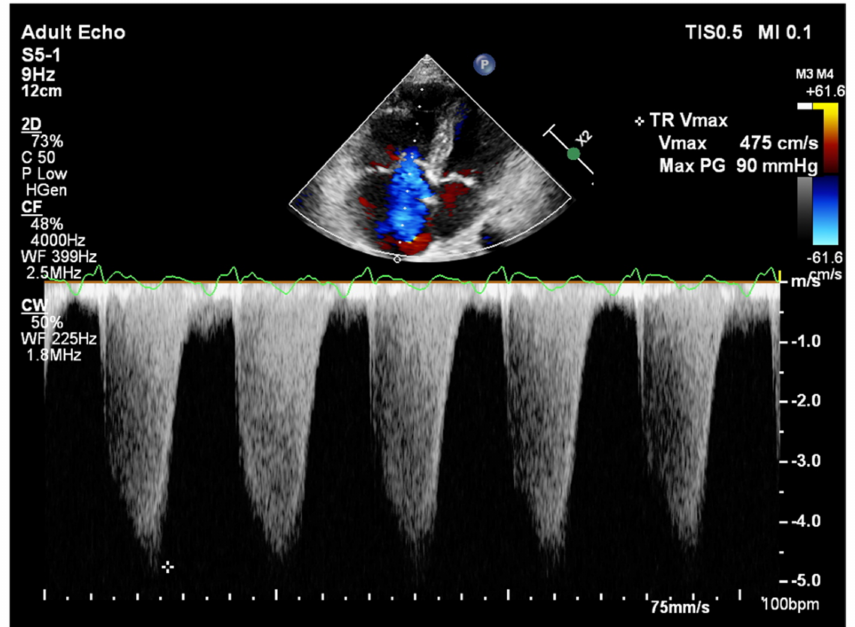
Figure 12. Doppler assessment of tricuspid regurgitant velocity (TRV). TTE, 4CH view. TTE: transtho- racic echocardiography; 4CH: